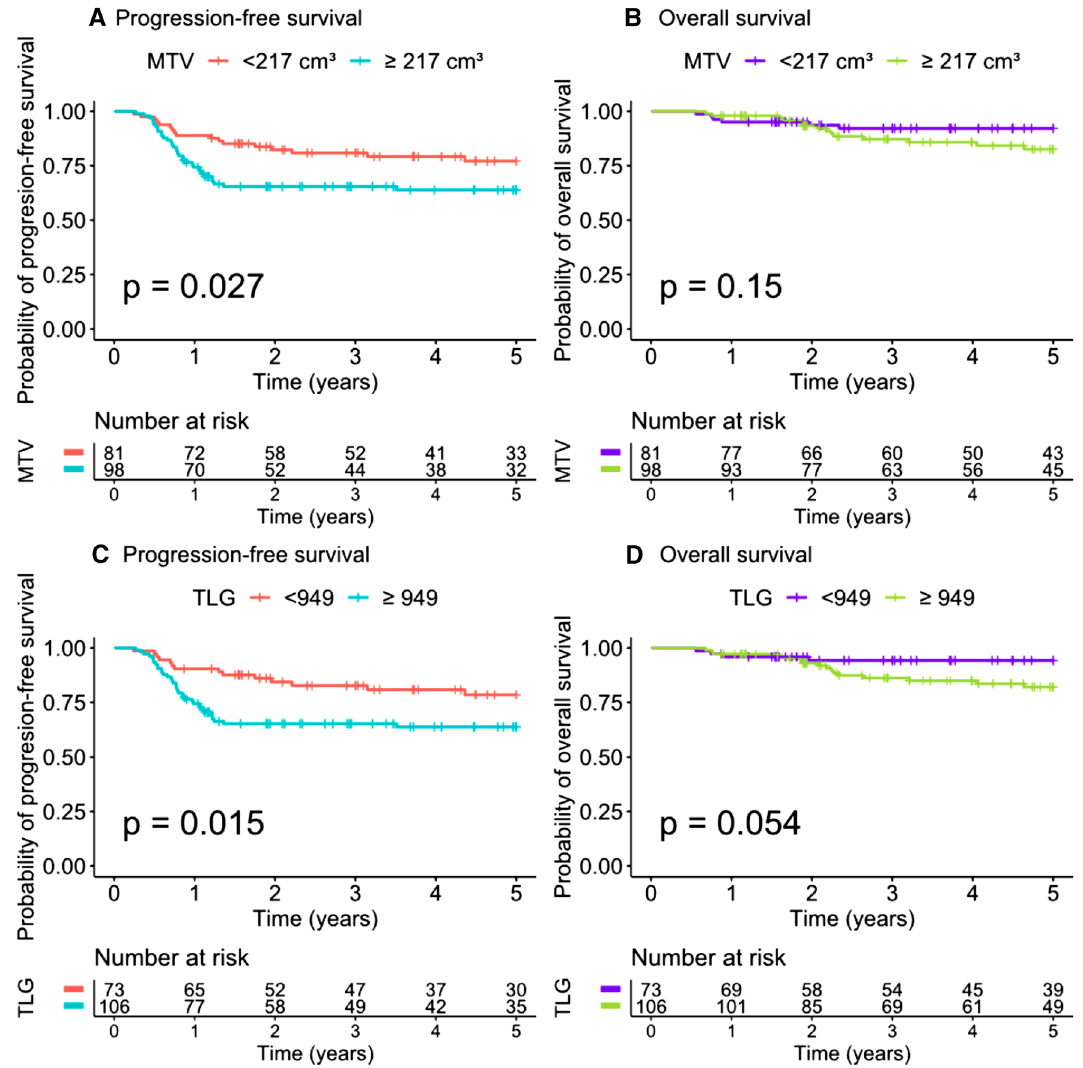
Figure 2. Kaplan Meier analysis of 5-year progression free survival and overall survival for total metabolic tumour volume (TMTV) and TLG (whole